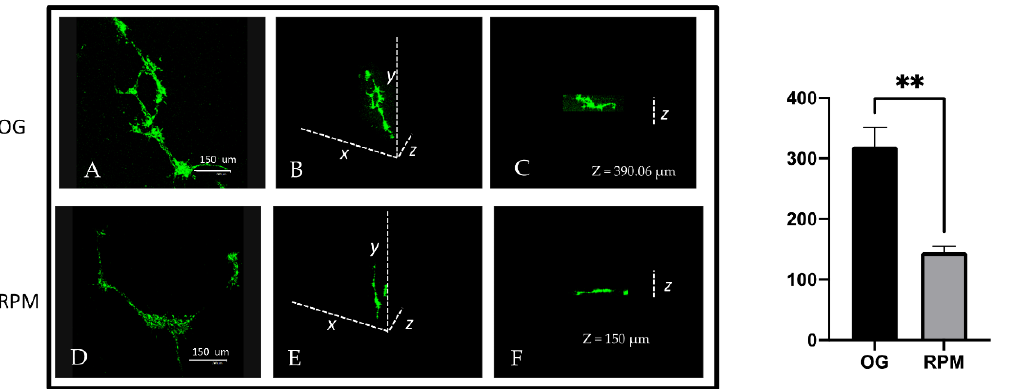
Figure 6. Cells (green) were cultured on GFR Matrigel under normal gravitational ( A – C ) and microgravity conditions ( D – F ) for 24 h. A, D represent the confocal maximum projection. B, E represent 3D projection. C, F show the depth analysis. As shown in this figure, cells maintained at unit gravity invaded the matrix to a depth of about 390.06 µm (C), while cells maintained under a microgravity condition were able to invade to a depth of about 150 µm (F). The graph indicates the mean value ± SE of depth along the zeta axis measured at a 4-spatial series. (** 1 g versus RPM p < 0.01; scale bar 150 µm.).